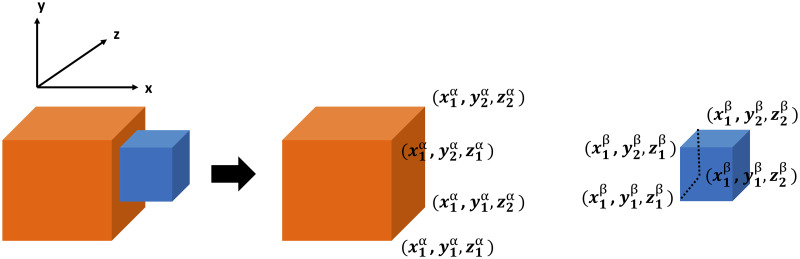
Coordinate details of the two cubes that touch each other from side.